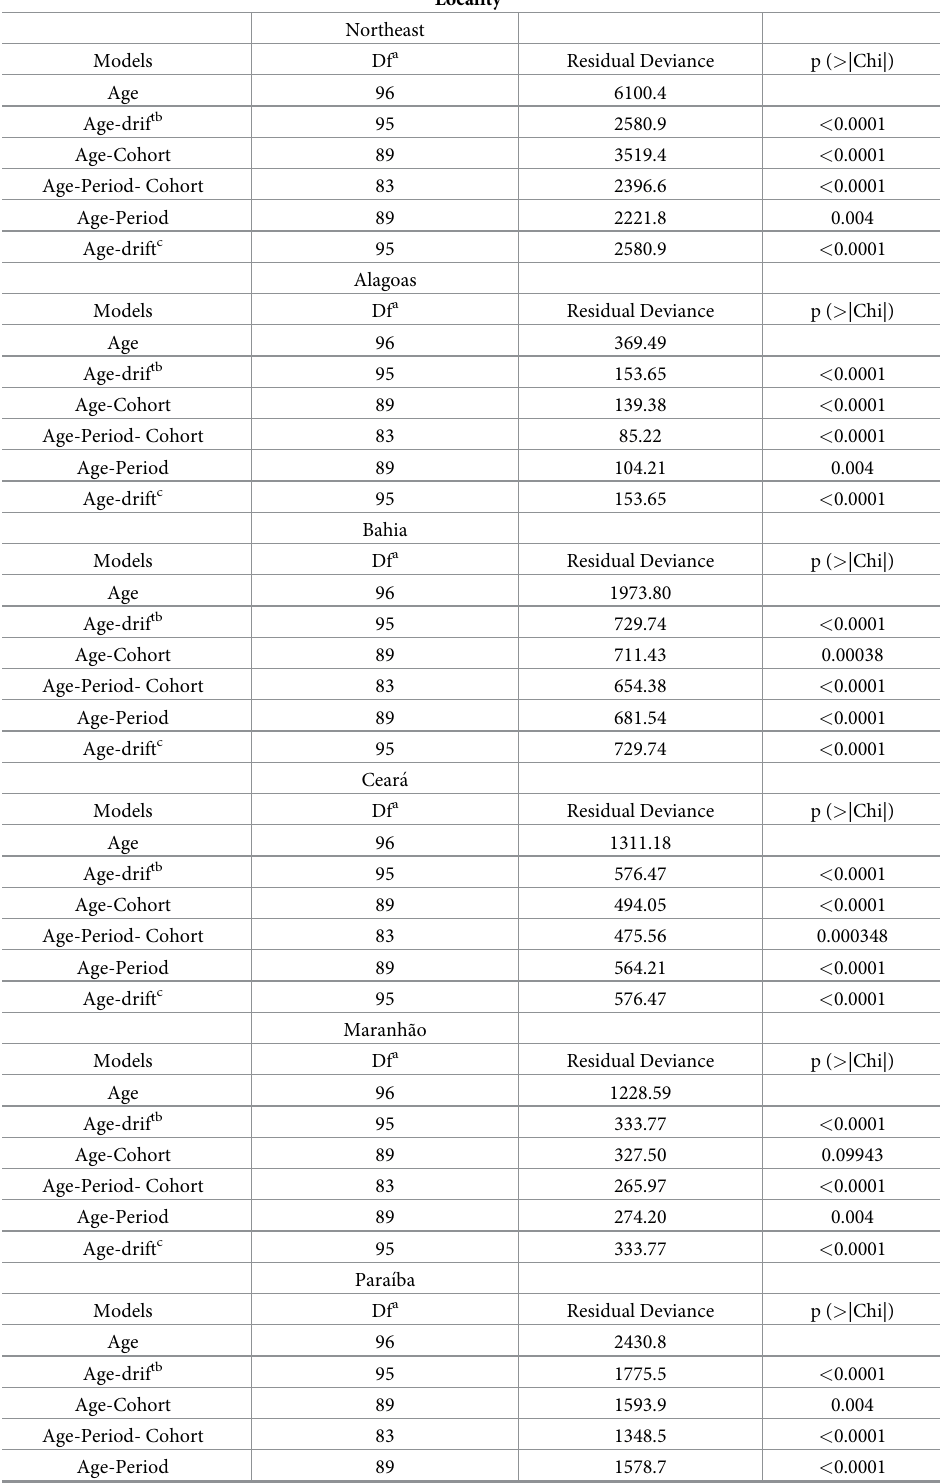
Table 5. Deviance an p-value analysis in sequential construction of age, period and cohort